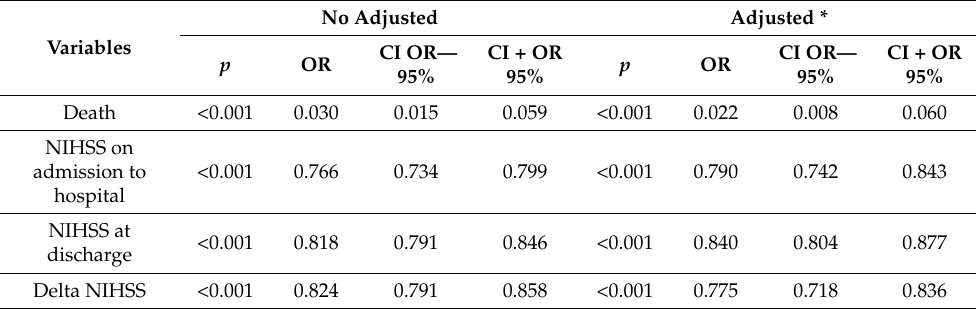
Table 2. Multivariate regression model for patients taking